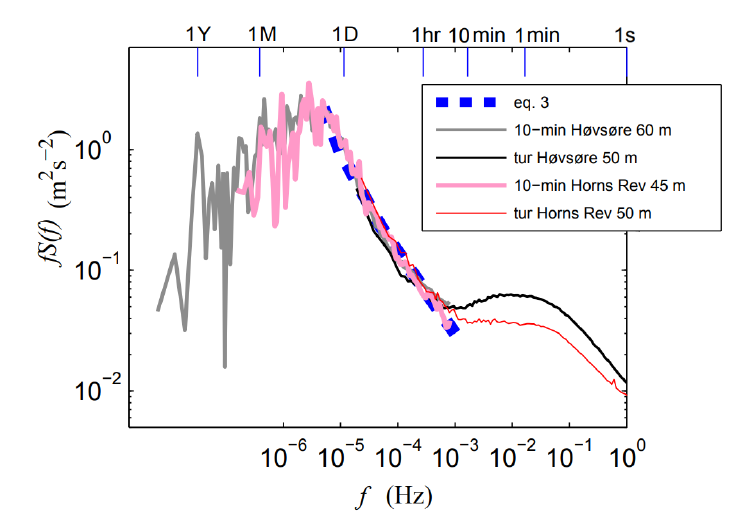
Figure 1. Power spectral density (PSD) of wind speed with corresponding timescales denoted atop. High frequency sonic measurements are used to devise the onshore (black) and offshore (red) lines. Reproduced with modifications from Larsen et al. [4] with permission from Springer